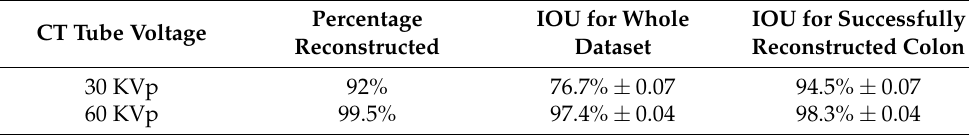
Table 4. Low-Dose reconstructed CT segmentation results